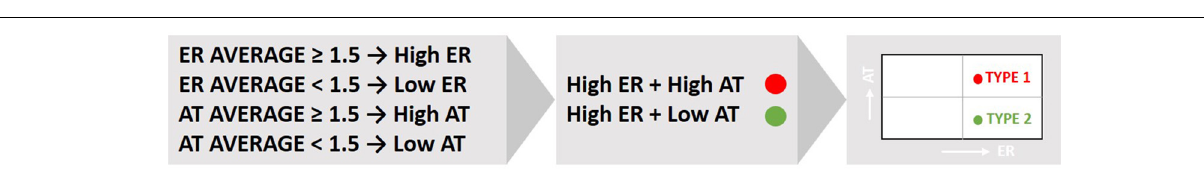
FIGURE 2 | Diagram summarizing the process of classifying the areas suggested based on scores regarding Ecological Relevance (ER) and Anthropogenic Threats (AT). The red color represents Type 1 areas and the green refers to Type